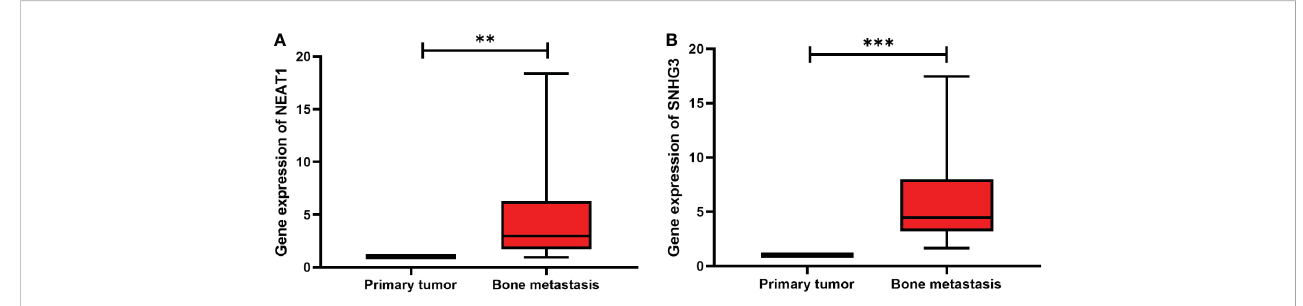
FIGURE 8 Expression levels of two lncRNAs in primary tumors and bone metastasis of prostate cancer. (A) NEAT1; (B) SNHG3. ** p < 0.01, *** p <